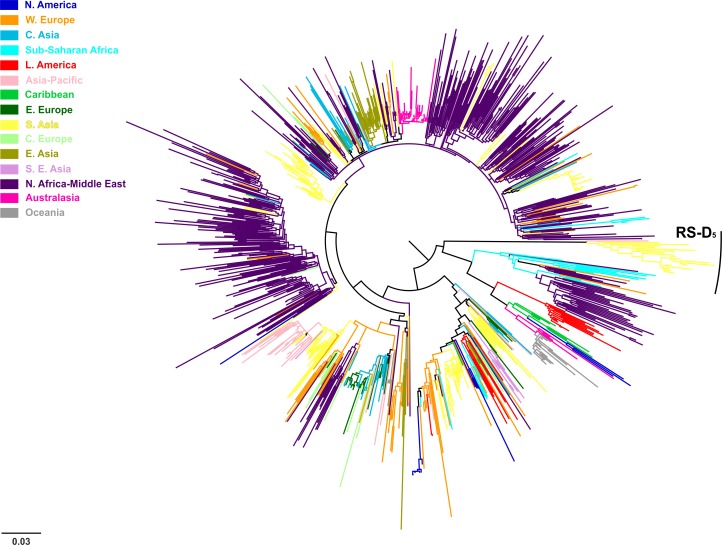
Midpoint rooted phylogeographic tree on HBV genotype D sequences after the inclusion of RS-D5.